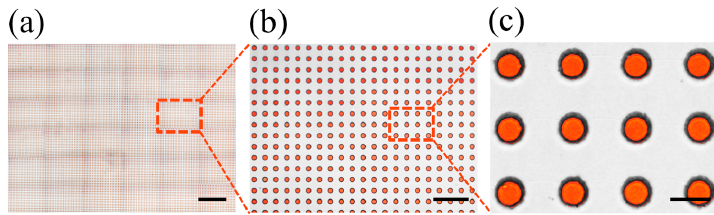
Figure 5. Microscopic images of the ultrahigh-throughput FDA using 50 μ m wells. ( a ) Large-scale scan of 36 images containing more than 14,000 wells and ( b , c ) zoomed-in images of trapped